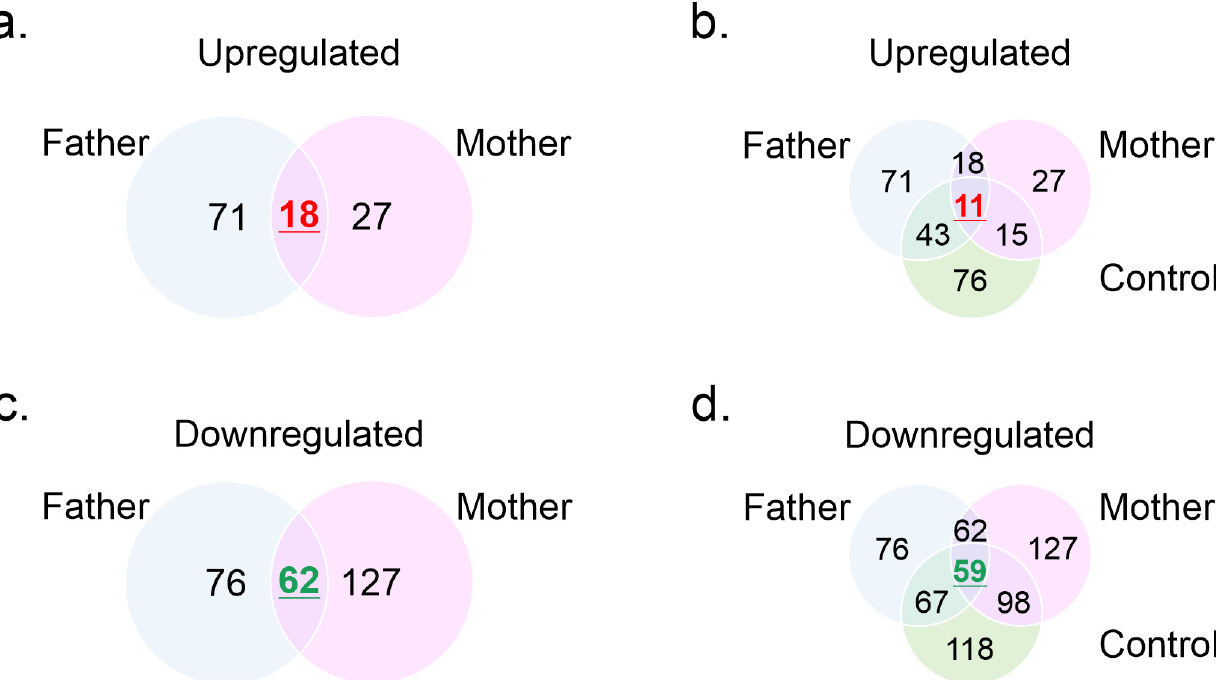
Figure 4. Mass spectrometry analysis profiles from human plasma samples. Plasma samples from proband, father, mother, and four healthy children controls, were analyzed by MS. Proteomic profiles were determined using proteomic data from father, mother, or healthy children controls as reference (denominator). Fold change cutoff was set when proteins with quantitative ratios above 2 or below 1/2 were deemed significant. Figure shows Venn diagrams of circulating protein upregulated ( a , c ) and down-regulated ( b , d ) between groups.